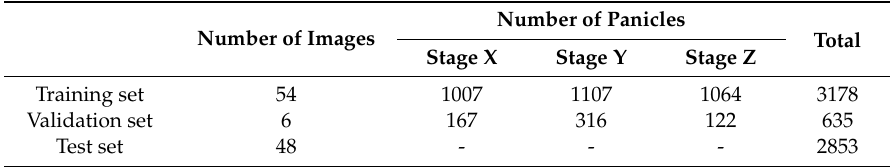
Table 2. Ofpaniclesintraining, validationandtestimagesets. Thetestsetconsistedofmanualpaniclecounts per tree from [21] and Canon camera images of those trees (no panicle stage categorization was